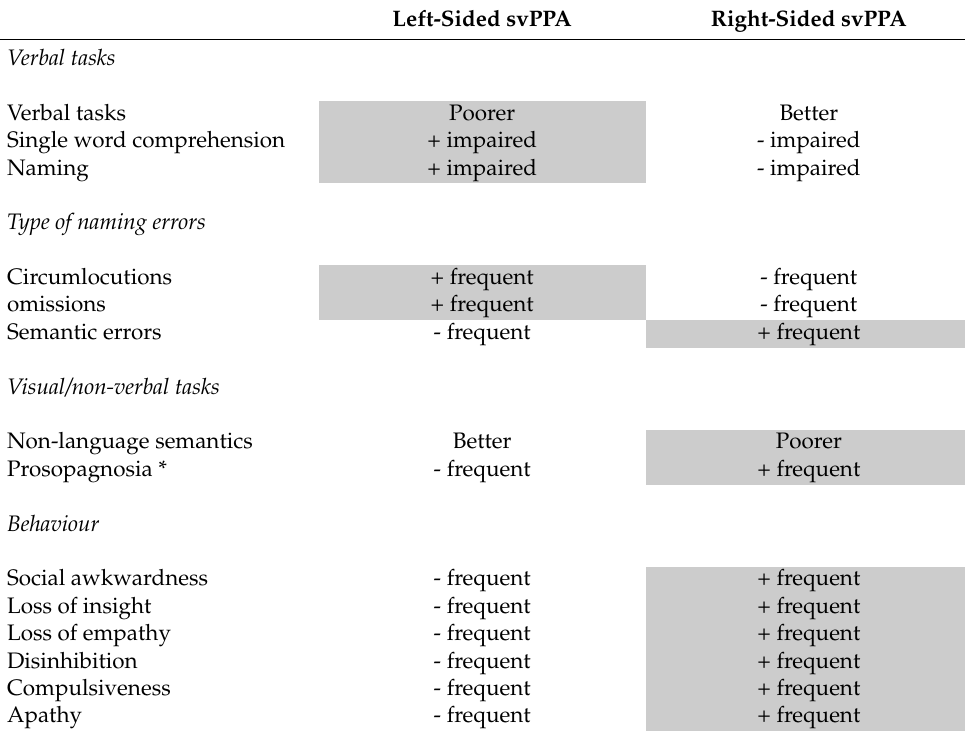
Figure 2. ( A.1 ) Axial T1 MR image: anterior temporal lobe displaying marked atrophy on the left pole. ( A.2 ) Coronal T1 MR image: marked left temporal atrophy with dilation of the temporal horn and left hippocampal shrinkage. ( B.1 ) Axial T1 MR image: anterior temporal lobe displaying bilateral atrophy more marked on the right. ( B.2 ) Coronal T1 MR image: marked right temporal atrophy with dilation of the temporal horn and right hippocampal shrinkage. Table 1. Differences between right and left variant: implications for clinical